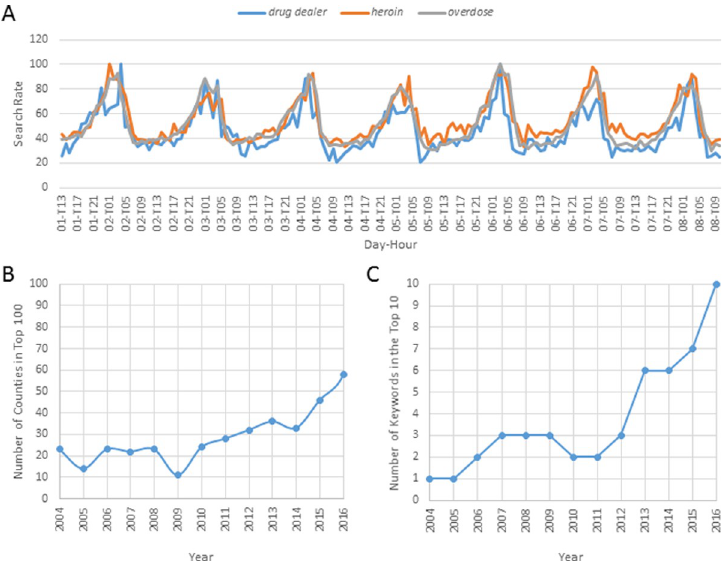
Fig 1. Dynamic nature of opioid and search rates. (A) Search Rates of 3 Drug-Related Terms for October 1, 2019– October 8, 2019; (B) For Each Year, Number of Counties in the Top 100 (by reported overdose death [ODD] Rate) That Are Also in the Top 100 Counties in 2017; (C) For Each Year, Number of Keywords in the Top 10 (By Correlation with reported ODD Rates) That Are Also in the Top 10 Keywords Identified for 2017.